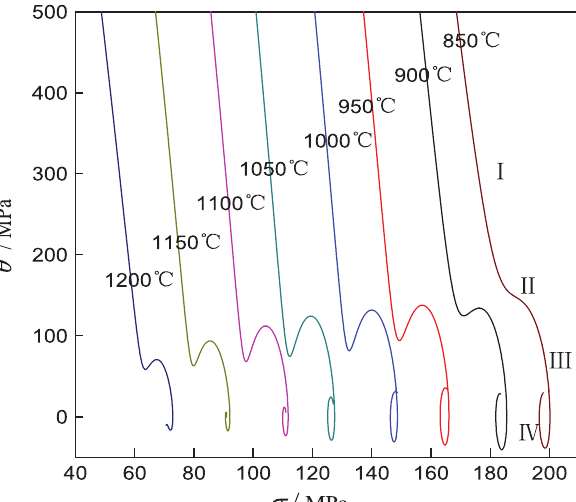
Figure 3: θ - σ curves of samples deformed under temperatures from 850°C to 1,200°C.